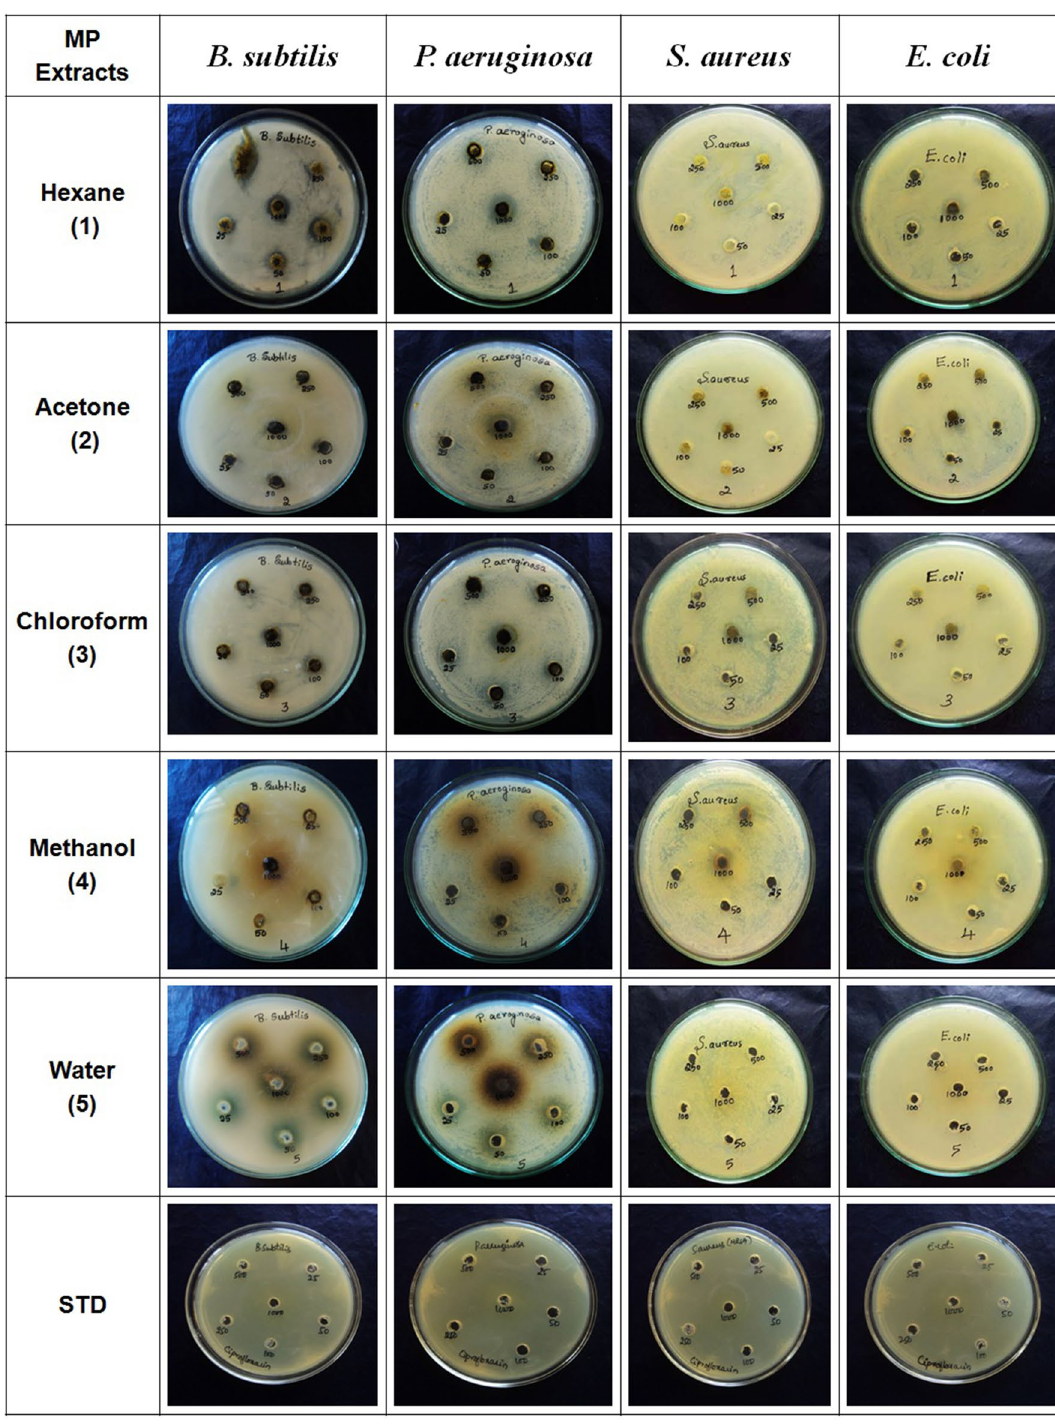
Figure 2. Antibacterial activity of different leaf extracts of M. paniculata against B. subtilis, aeruginosa, S. aureus and E. coli. The drug ciprofloxacin was used as positive